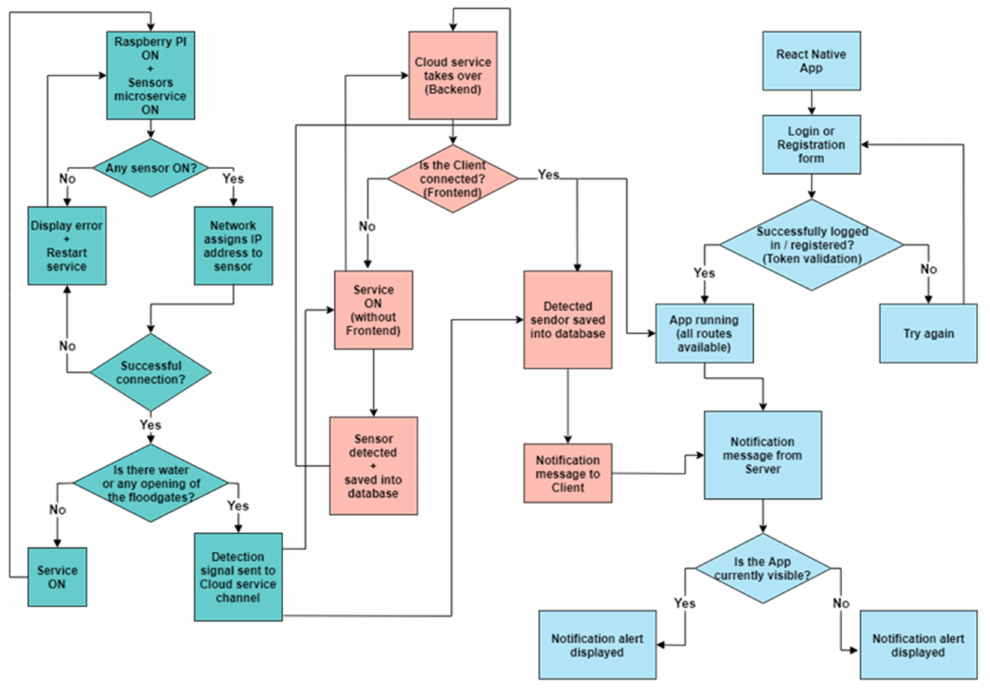
Figure 9. Flow diagram of the entire system with the sensors’ microservice, the server (backend) in the cloud, and the mobile application client